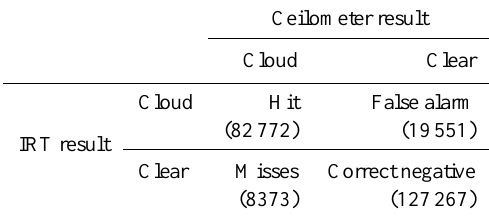
Table 1. Contingency table for cloud detection by the infrared py- rometer (IRT) and ceilometer. The estimated proportion of correct- ness is 88.3% and the probability of detection is 90.8%.